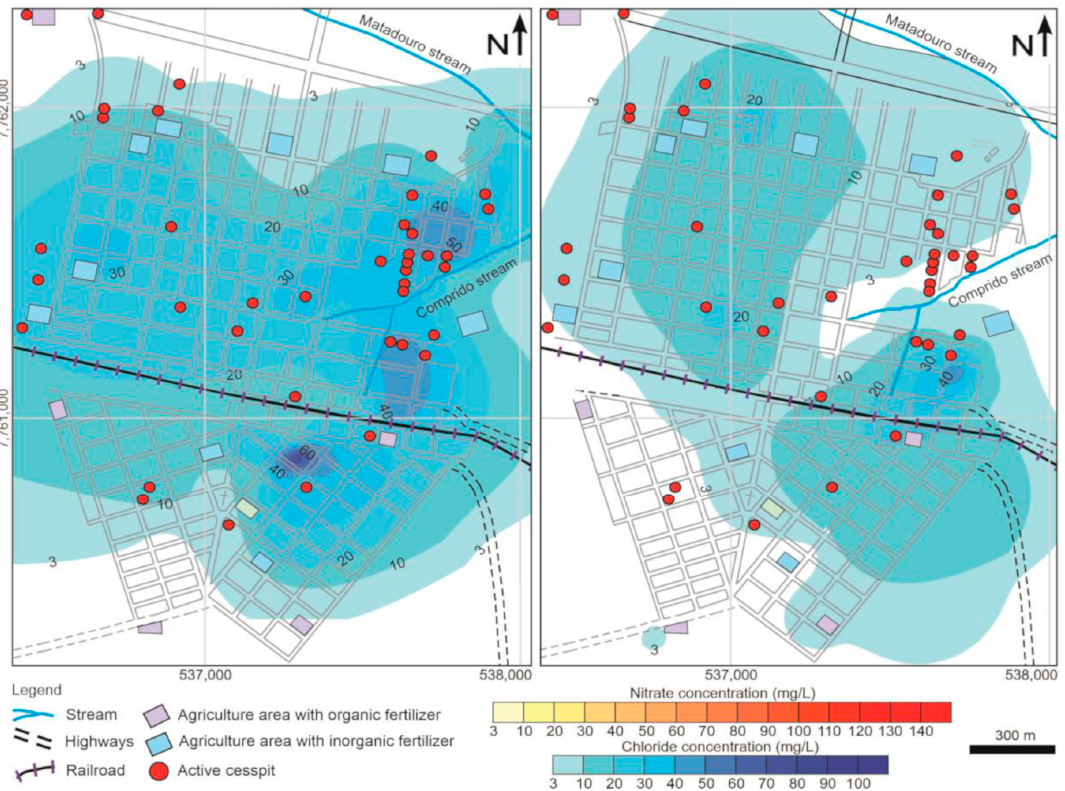
Figure 6. Nitrate ( top ) and chloride ( bottom ) isoconcentration maps indicating that the values are higher in the shallow (SZ) than the intermediate (IZ) zone.